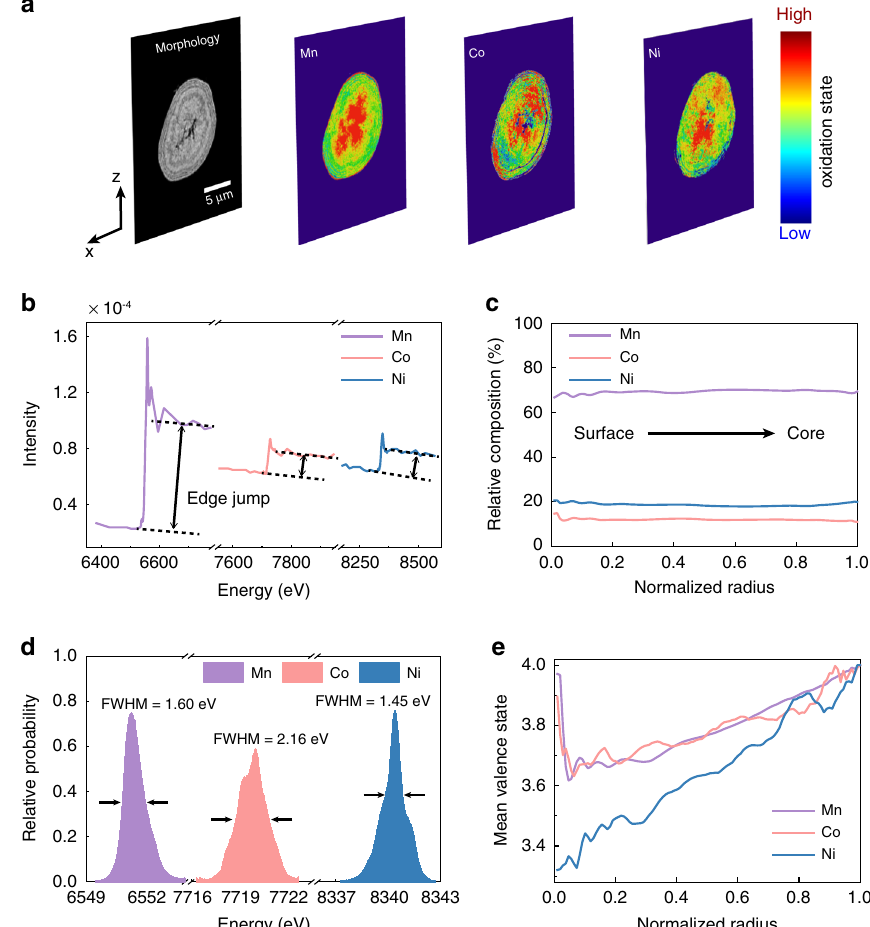
Fig. 3 The spatial variation of the composition and the valence states of Mn, Co, and Ni in a charged (to 4.8 V) LirNMC particle. Panel ( a ) shows the valence states of Mn, Co, and Ni over the central xz slice of a charged LirNMC particle. Panel ( b ) illustrates the x-ray absorption spectroscopic fi ngerprints over a typical voxel in the reconstructed spectro-tomographic data. The edge jump is proportional to the relative elemental concentration and is utilized to quantify the elemental distribution in the particle volume. Panel ( c ) is the depth-dependent elemental concentration over the studied particle, suggesting the compositional homogeneity throughout the particle. Panel ( d ) is the relative probability distributions of the edge energy over the K-edges of Mn, Co, and Ni, respectively. Panel ( e ) shows the transition metal cations ’ valence states variation over different